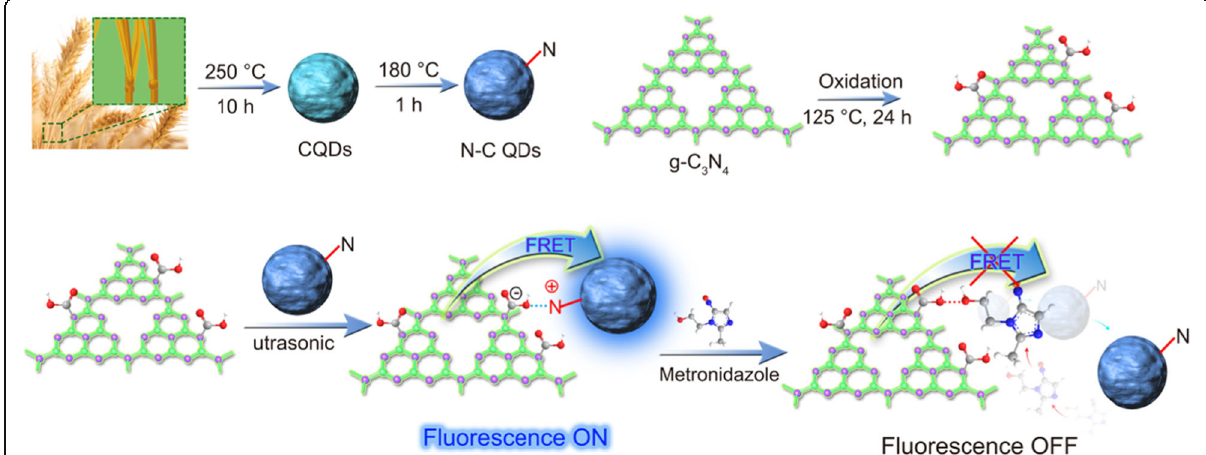
Fig. 7 Schematic mechanism of Detection MNZ by g-C 3 N 4 /N – C QDs QDs composites